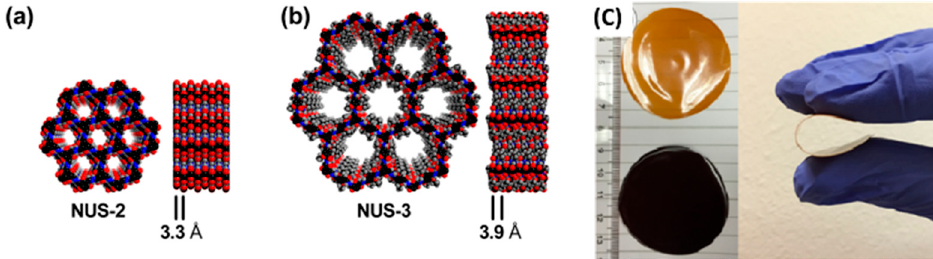
Figure 7. Crystal structures, showing a pore size of ( a ) NUS-2 as compared to ( b ) NUS-3, and ( c ) photo images of 20 wt %NUS-2@Ultem (brown) and 20 wt %NUS-3@Ultem (black). Reprinted with permission from ref. [130] . Copyright 2016 American Chemical Society.